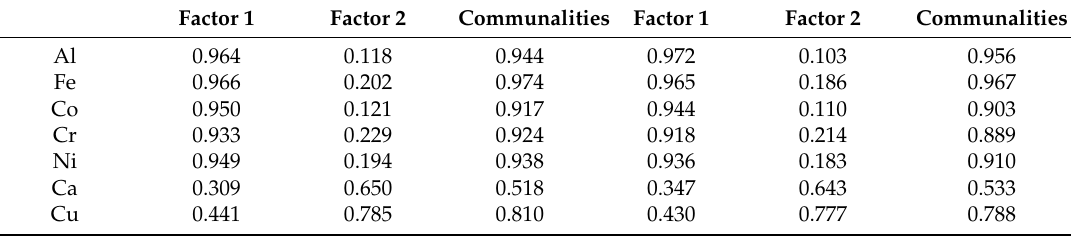
Table 2. Factor loadings of PAHs and potentially toxic elements (PTEs), after Principal Component extraction and Varimax rotation. Factor analysis (FA), including organic carbon (OC) and clay, is also shown. Coefficients higher than 0.5 are marked in bold. Communalities, eigenvalues, and the cumulative explained variance (CEV in %) by the factors are also